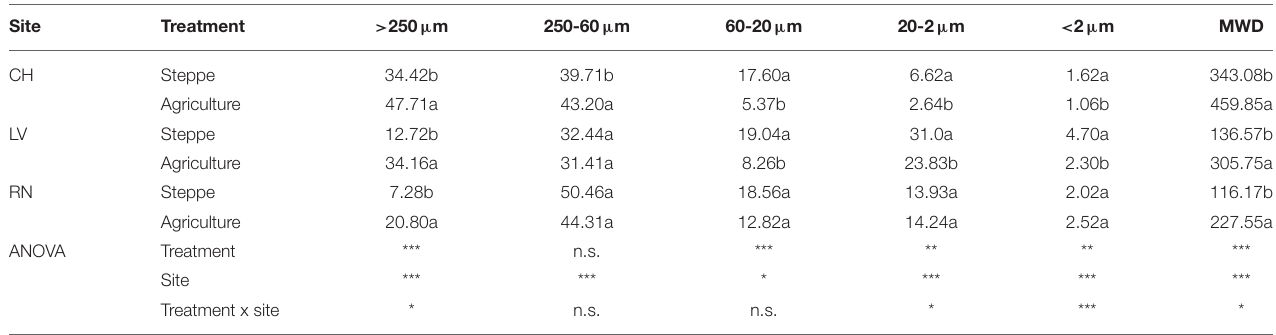
TABLE 2 | Soil aggregate fractions determined by wet